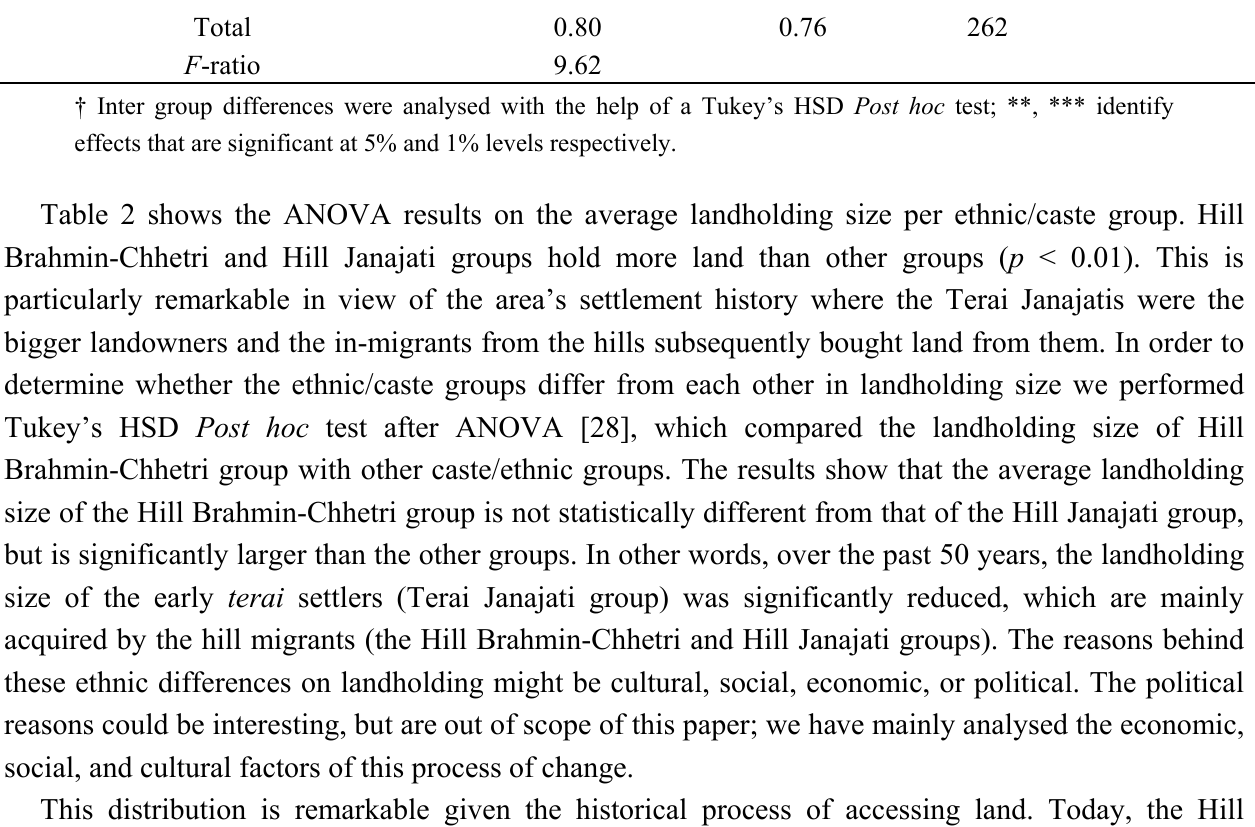
Table 2. Average landholding size among ethnic groups. Source: Household survey 2009. Total Land (ha) Ethnicity Mean SD N p -Value † Hill Brahmin-Chhetri 0.97 0.80 152 Hill Janajati